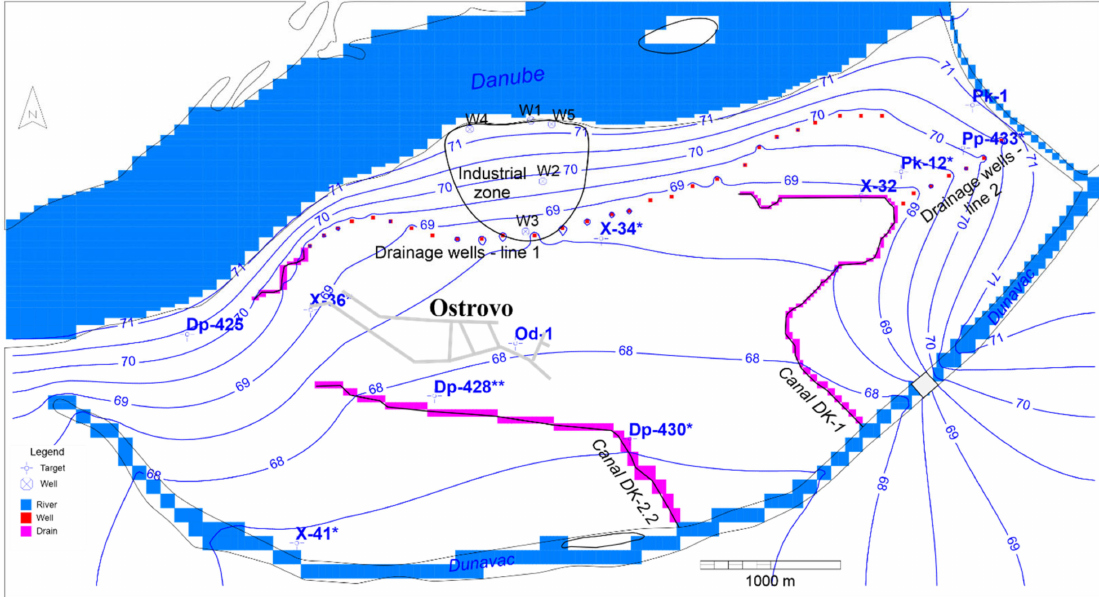
Figure 6. Water level distribution of the second model layer (sandy sediments) at high stages of the